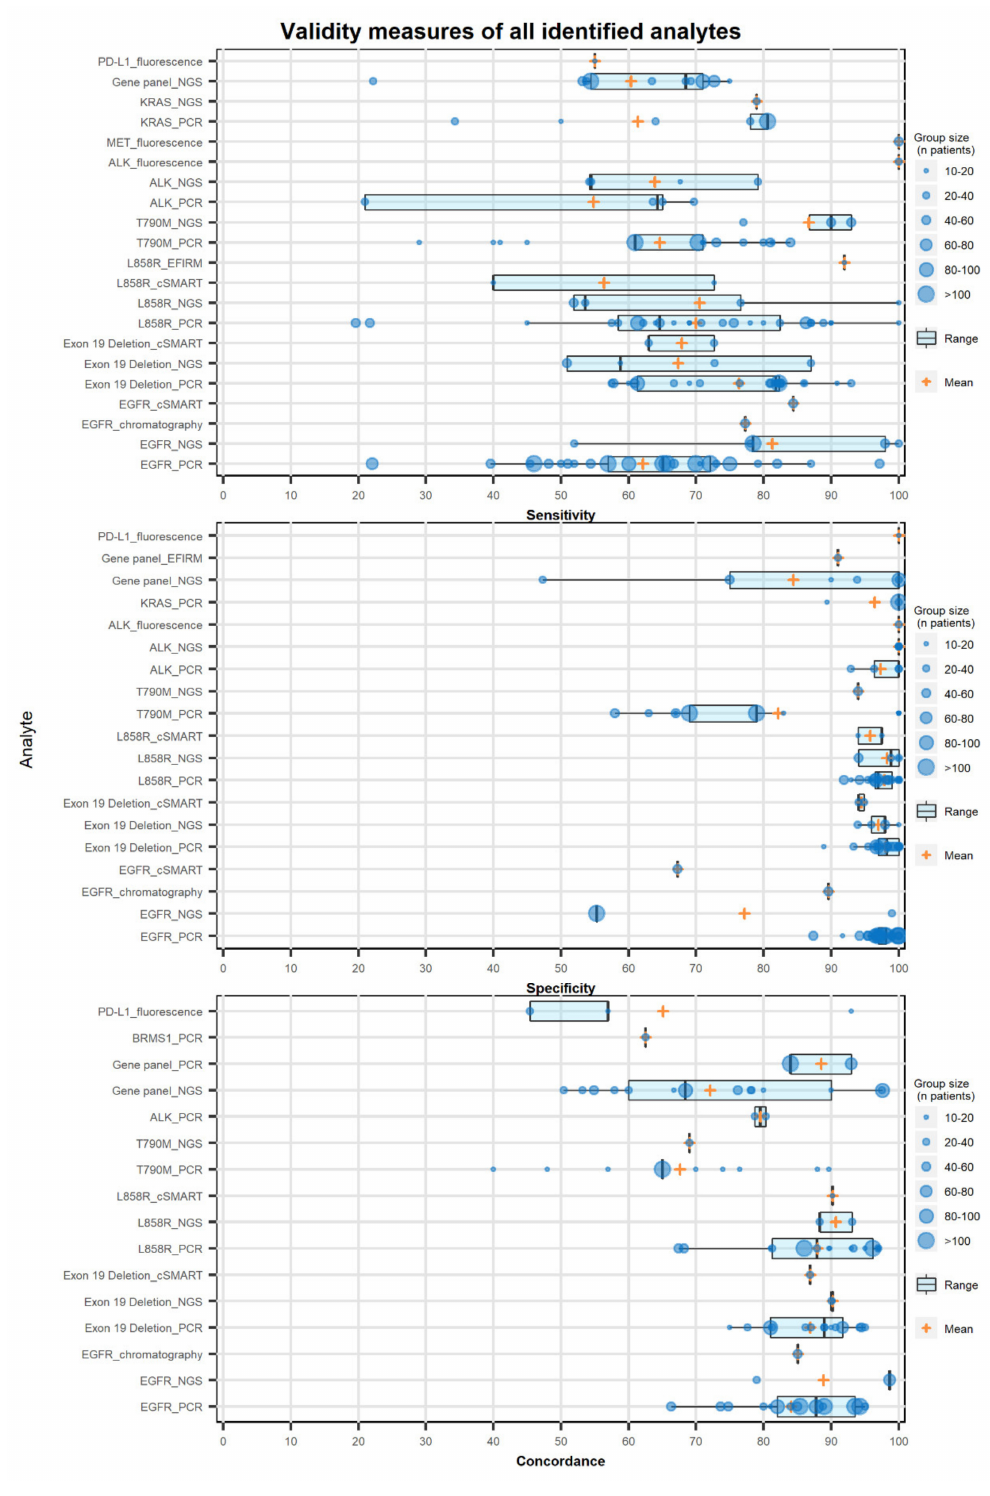
Figure 2. Validity measures of all identified analytes, including the sensitivity, specificity, and concordance of liquid biopsy results compared to matched tissue samples. The y-axis presents each of the reported biomarkers with analysis platform used and separated through an underscore (e.g., EGFR_NGS). The size of the “circle” (seecaptionrightofthefigure)depictsthenumberofpatientsinwhomthebiomarkerwasdetectedinthetissue sample. Likewise, the “plus” shaped marker depicts the average of the reported values. A boxplot is used to present the range of the reported values, the box represents the 25 th and 75 th percentiles, while the whiskers extend to a maximum of 1.5 times the inter-quartile